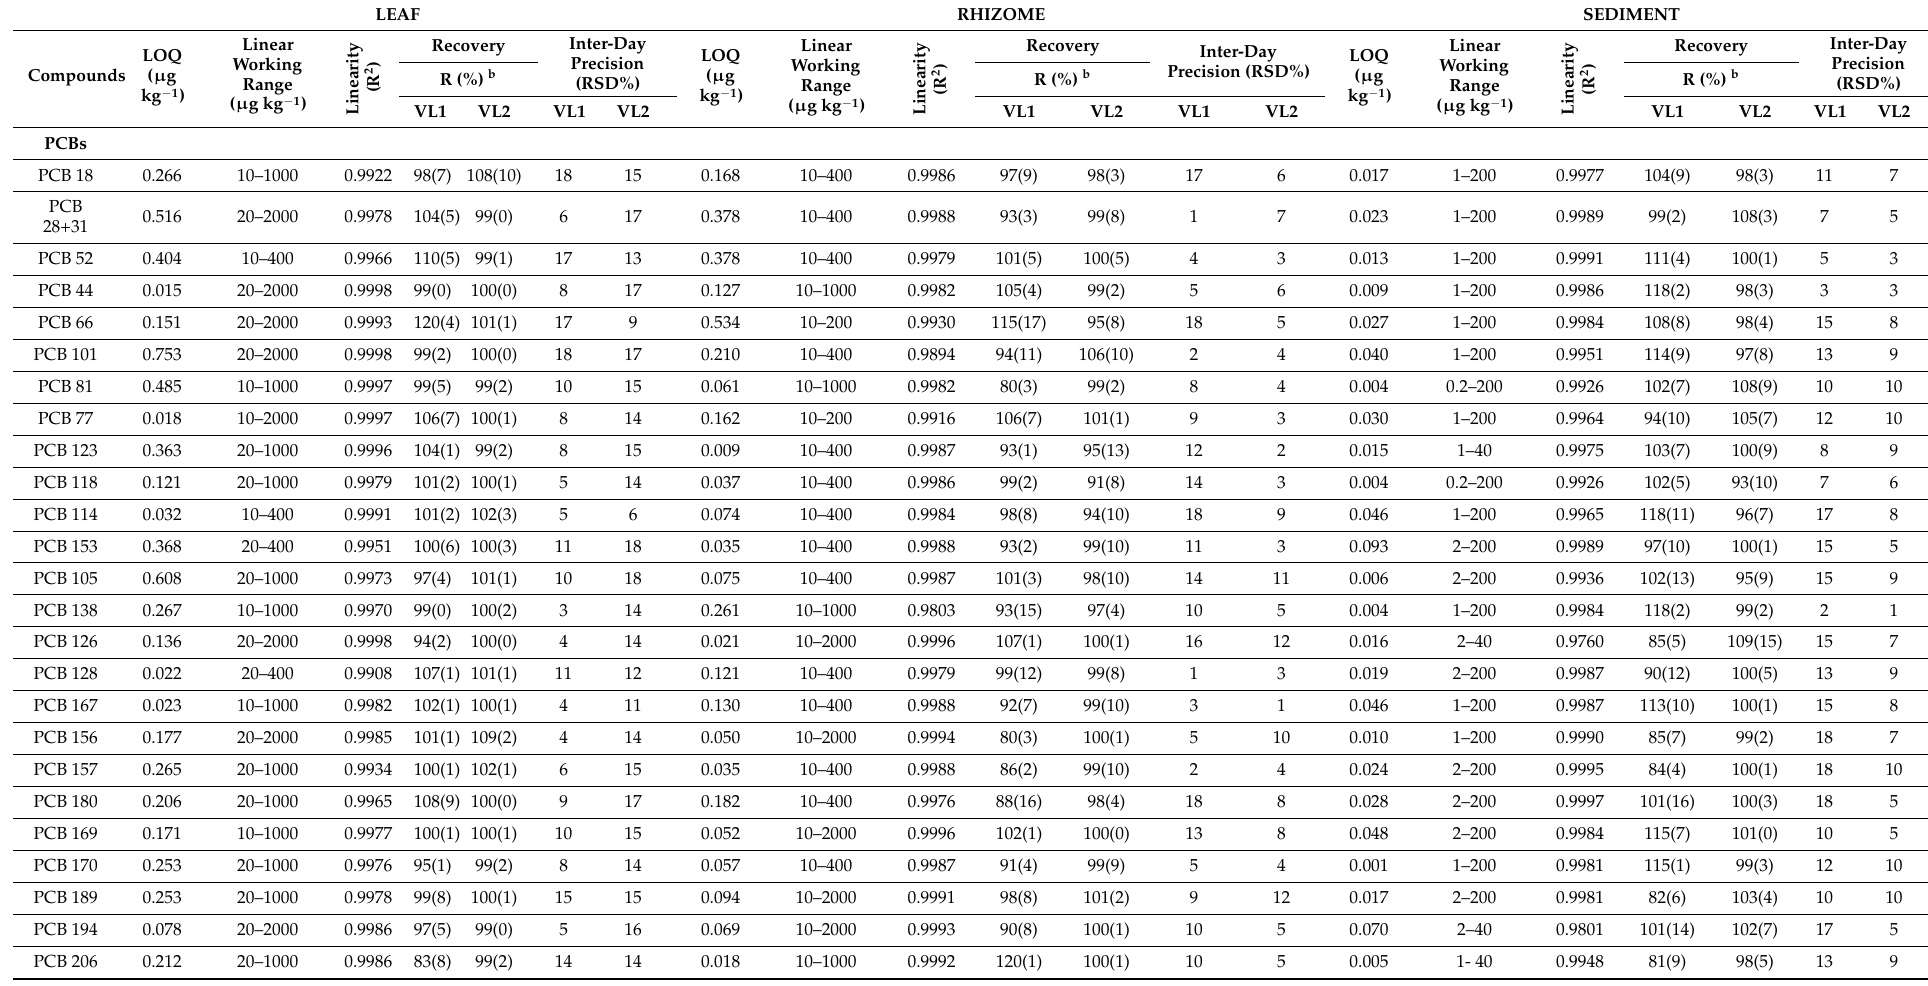
Table 1. Validation results for the analytical methods developed in this study for the studied matrices at two concentration levels a . LEAF RHIZOME